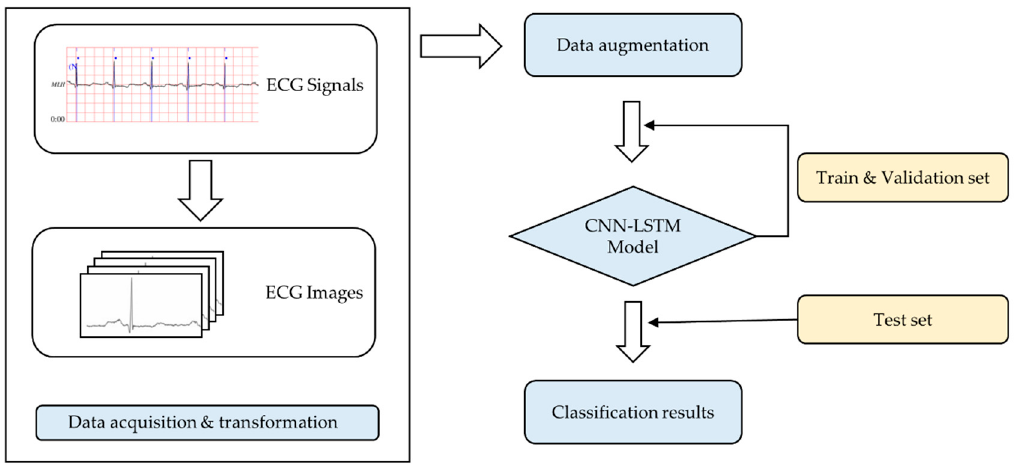
Figure 1. Overall procedures processed in ECG arrhythmia classification.